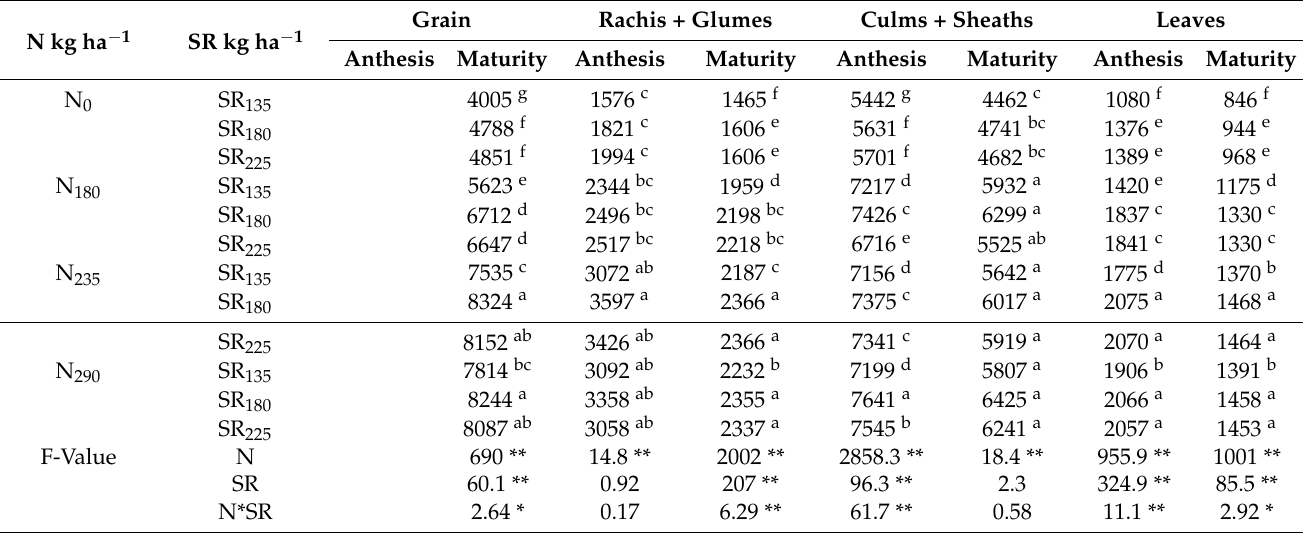
Table 3. Effects of N and SR on DM accumulation and partitioning at the anthesis and maturity stages in